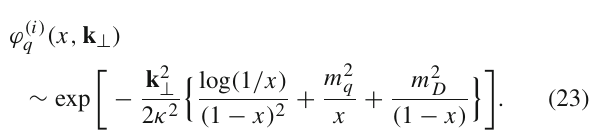
(cid:2) ( t ) , are defined in the E q n 0 (cid:2) ( x , 0 , t ) and H q n 0 ( t ) , and the A